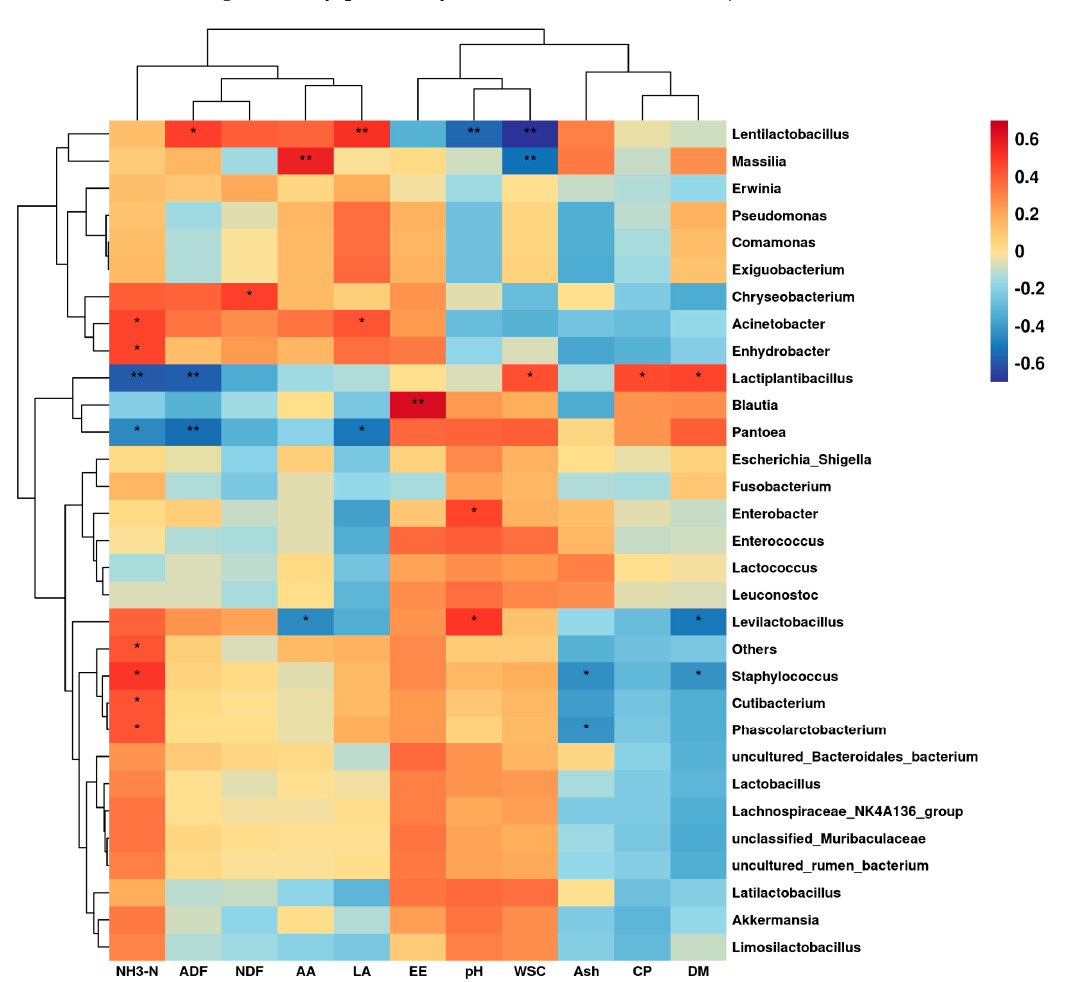
Figure 3. Correlation of bacterial at the genera-level with silage quality during anaerobic fermentation and aerobic exposure of silage. Red represents a positive correlation, while blue represents a negative correlation. *: Significant correlation at p < 0.05 level, **: Significant correlation at p < 0.01 level.